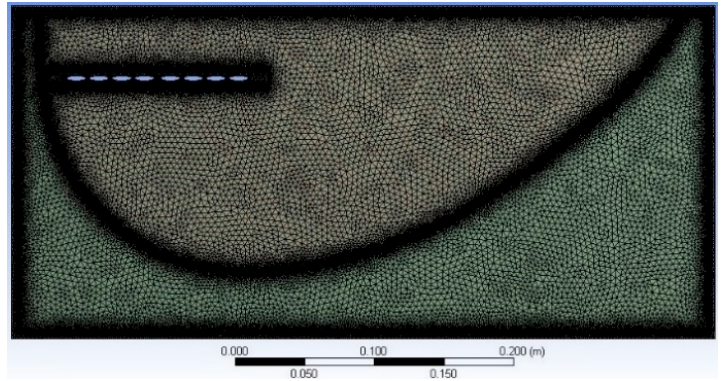
Figure 6. Mesh of the collector .